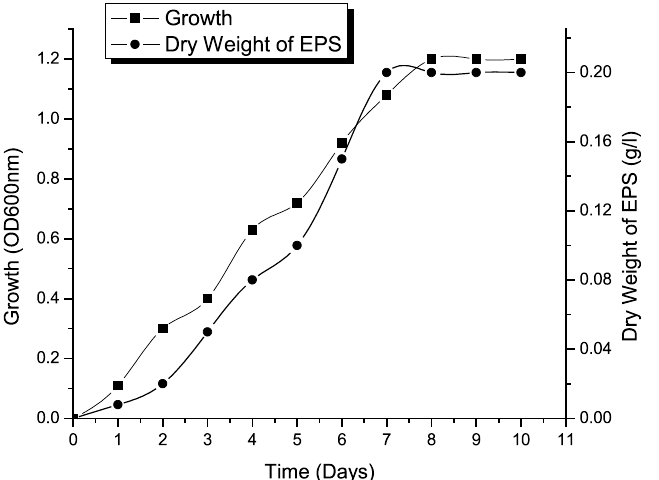
Fig. 1. Correlation between growth of Halomonas sp. NASH grown in IRAM and incubated at 37°C under shaken conditions for 10 days and EPS